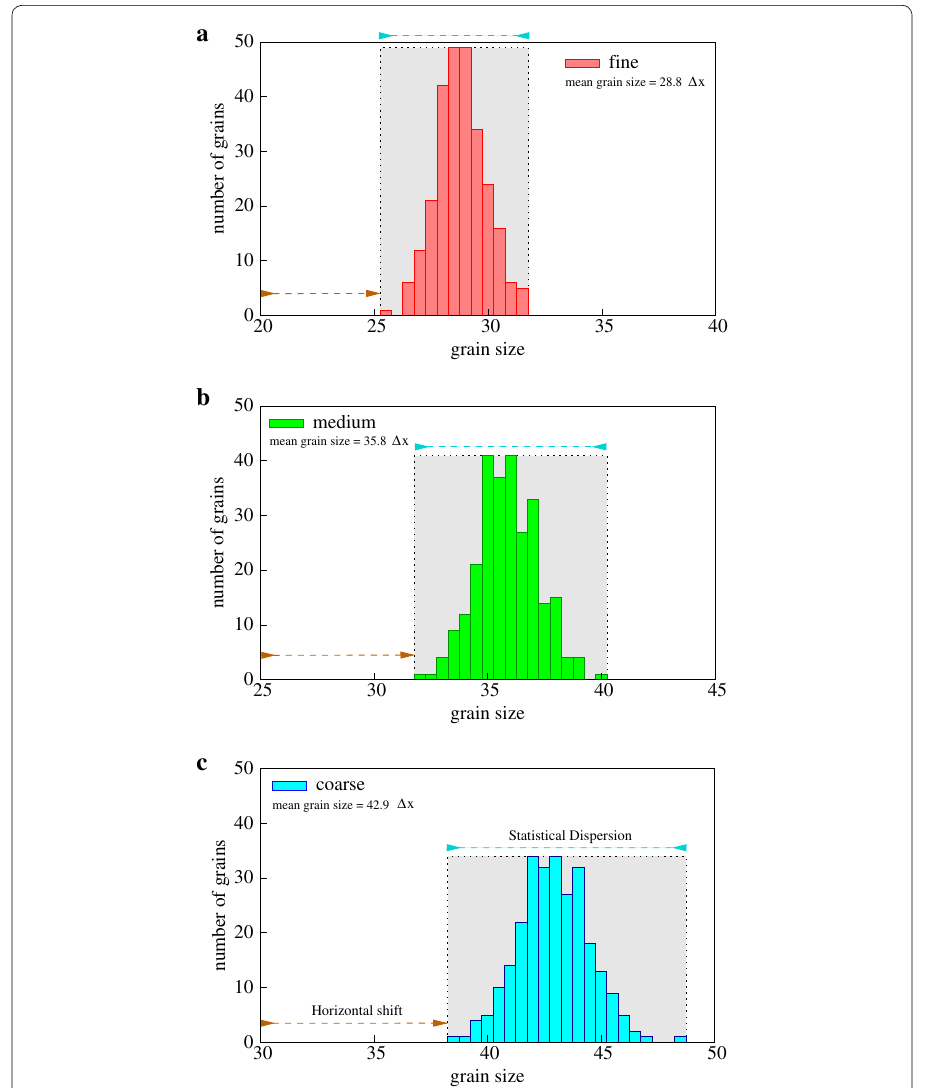
Fig. 7 Histogram plots of grain size distribution of the numerically cemented microstructure corresponding to the grain sizes: a r = 20 (cid:31) x , b r = 25 (cid:31) x , and c r = 30 (cid:31) x , respectively. The dotted boxed region (in gray ) is for visual illustration of horizontal shift and dispersion in the GSD with an increase in mean grain